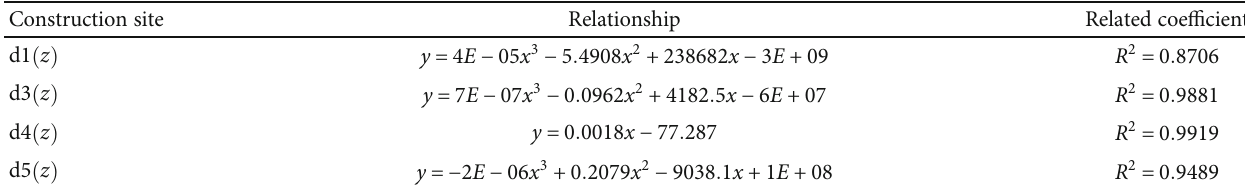
Table 7: The linear relationship of mining stress variation with time.